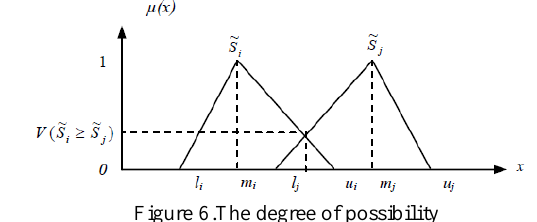
Figure 6.The degree of possibility